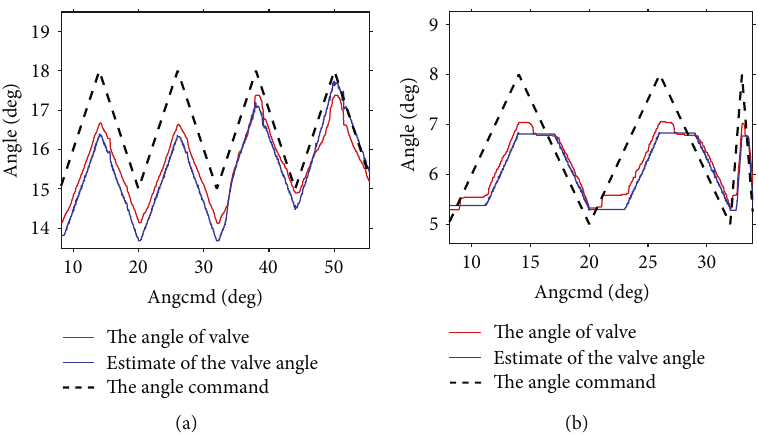
Figure 17: Valve estimates vs. actual measurements under cold-air experiment. (a) The response between 15 – 18 degrees. (b) The response between 5 – 8 degrees.